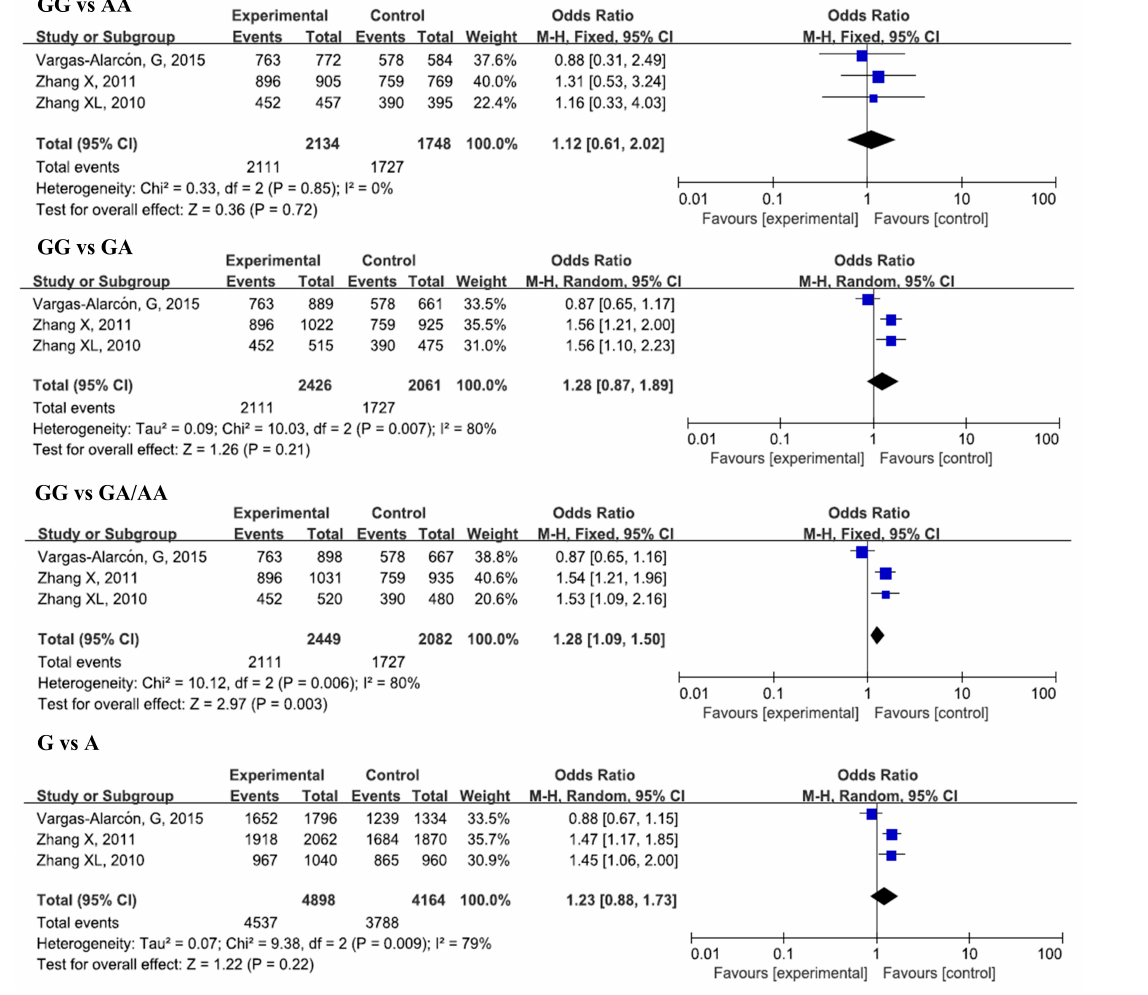
Figure 4. Forest plots of odds ratios for the association of IL-17A rs8193037 with risk of CAD.